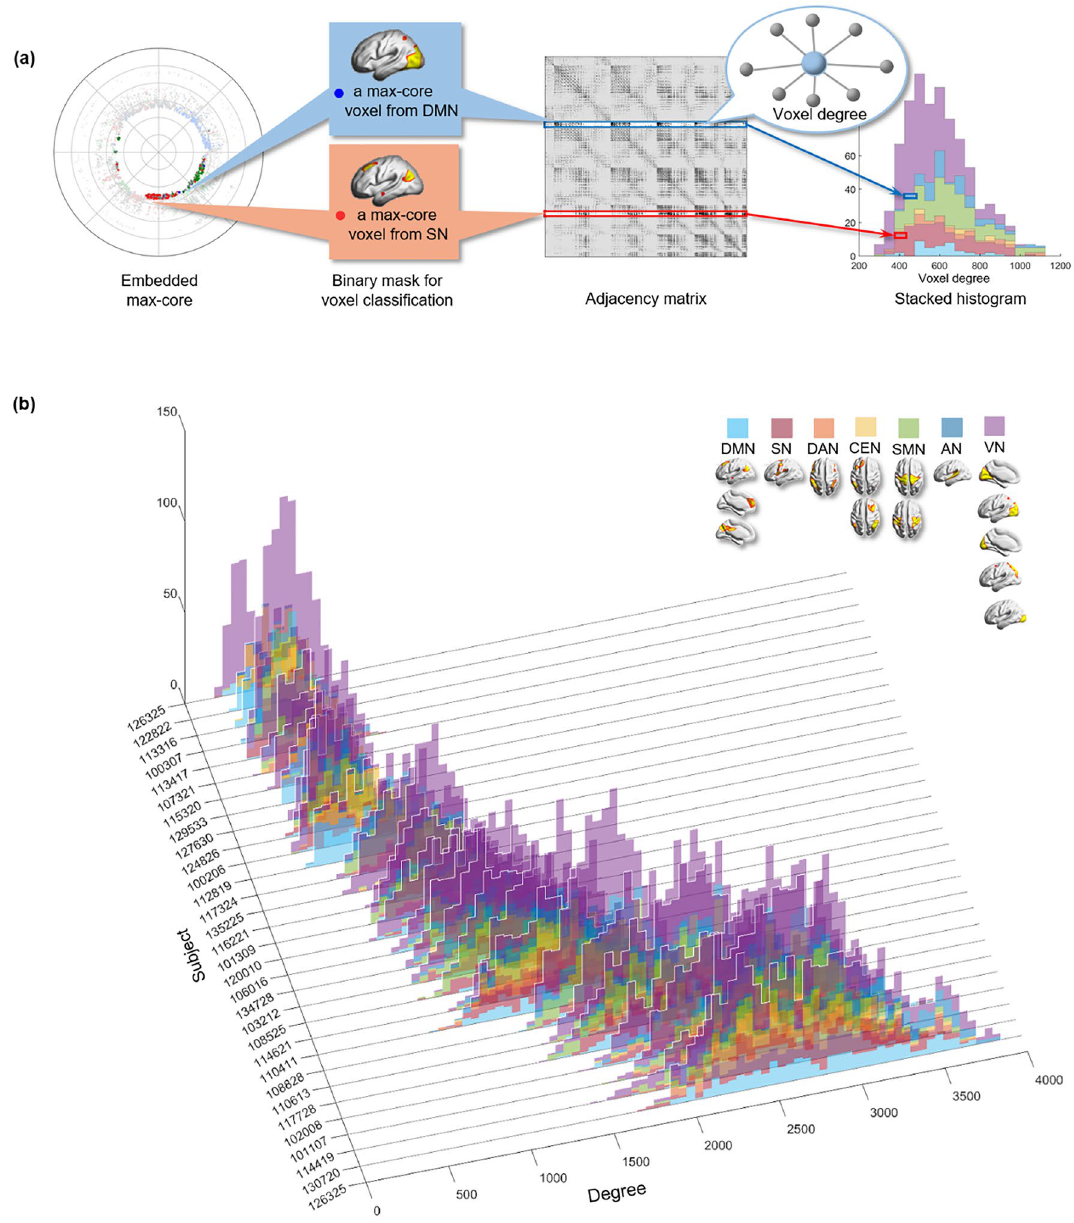
Figure 8. The stacked histogram of the degree distribution of k max -core voxels calculated from the adjacency matrix used as input. ( a ) After finding the k max -core of a subject with k -core percolation, we read the degree of each k max -core voxel on the adjacency matrix. We classified k max -core voxels into seven categorical independent components (ICs) and produced a stacked histogram showing each k max -core voxel’s affiliation and the voxel degree simultaneously. ( b ) We depicted k max -core of 30 subjects. The voxel degrees of k max -core voxels and their affiliation are in different colors. k max -core voxels located on the right side of the histogram were deemed to have a greater degree initially in the adjacency matrix, indicating that they have connections with non- k max -core voxels as well as within k max -core voxels. In contrast, k max -core voxels on the left side of the histogram denote a relatively smaller voxel degree, implying that it has fewer connections with non- k max -core voxels and is thus almost confined to obtain connections with k max -core voxels. The histograms of 30 subjects were sorted in ascending order with the mean degree of the k max -core voxels in 3-dimensional correlates 60,61,69,70 . Further studies using both positive, negative correlation and for dynamics of functional con- nectivity hierarchy are warranted.